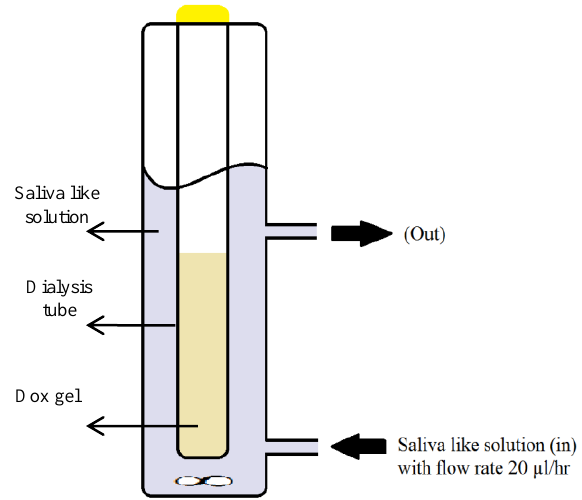
Fig. 1. Determination of the drug release by an in-house release